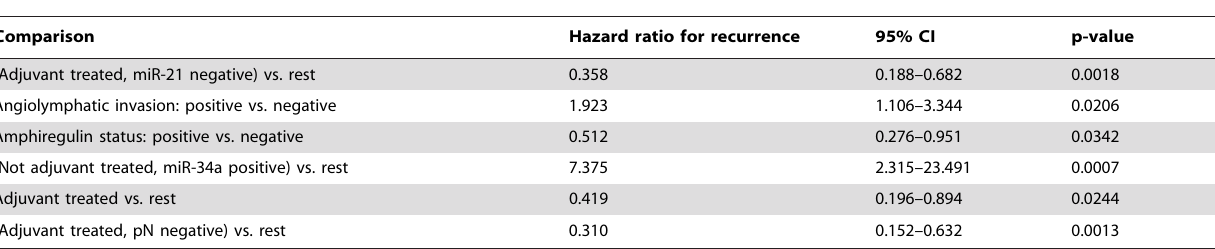
Table 4. Multivariate analysis of all patients: disease-free survival.